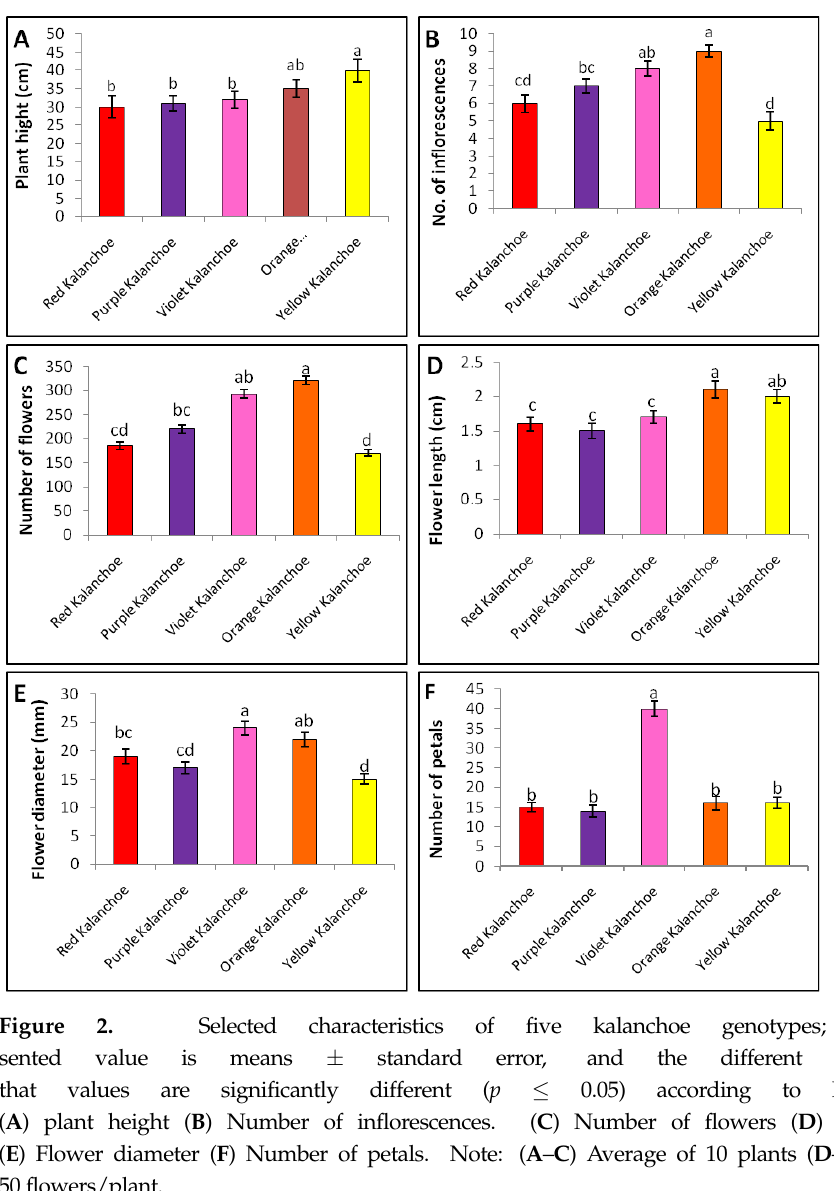
Figure 2. Selected characteristics of five kalanchoe genotypes; each presented value is means ± standard error, and the different letters mean that values are significantly different ( p ≤ 0.05) accord- ing to Fisher ’ sLSD 0.05 . A. plant height B. Number of inflorescences. Number of flowers D. Flower length E. Flower diameter F. Number of petals.Note: ( A – C ) Average of 10 plants ( D – F ) Average of 50